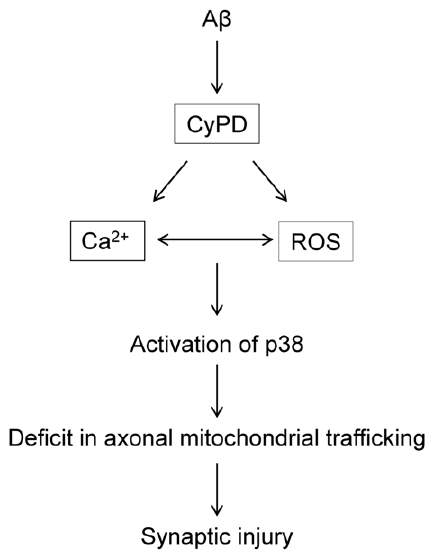
Figure 7. Working hypothesis. A b -Cyclphilin D mediates impair- ments in axonal mitochondrial transport. In the present of A b , there is an increase in the opening of CypD-mediated mitochondrial perme- ability transition pore (mPTP), leading to disruption of Ca 2 + balance and increase in reactive oxygen species (ROS) production/accumulation. Consequently, elevation of Ca2 + and oxidative activates downstream signal pathway p38 MAP Kinase contributing to mitochondrial dysfunction, deficits in axonal mitochondrial trafficking, eventually, synaptic damage.